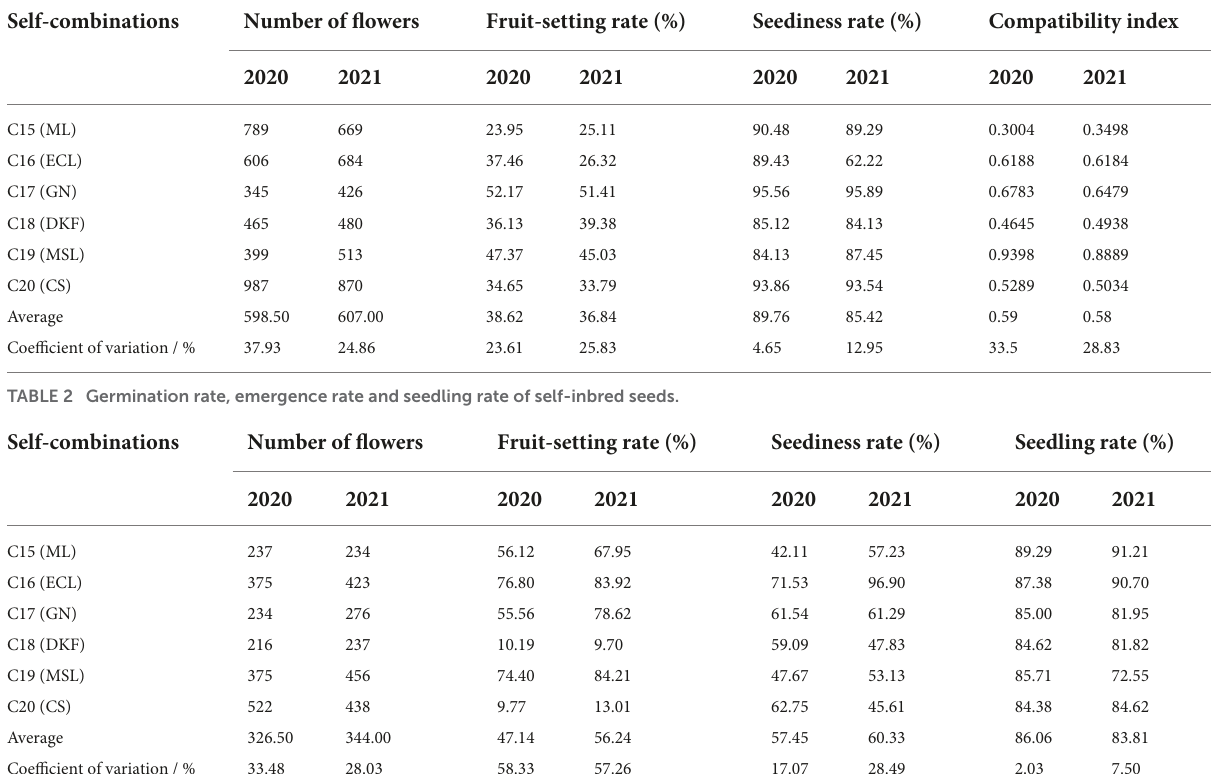
TABLE 1 Fruit-setting rate, seediness rate and compatibility index of selfing combinations. Self-combinations Number of flowers